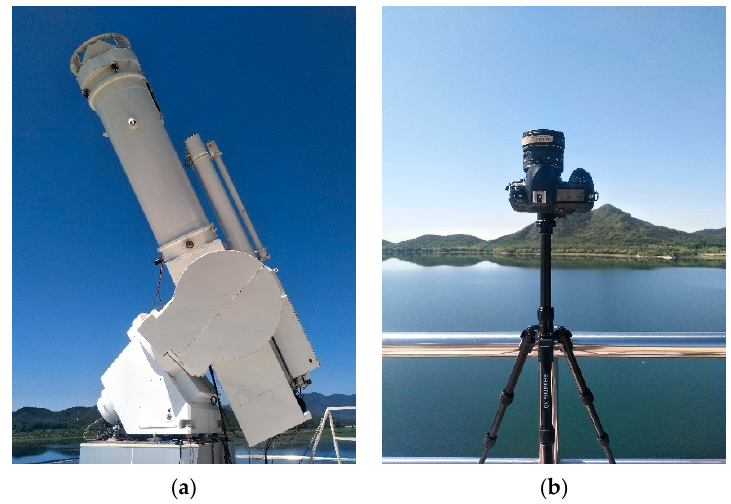
Figure 1. Telescope ( a ) and fisheye camera ( b ) for polarization observation.